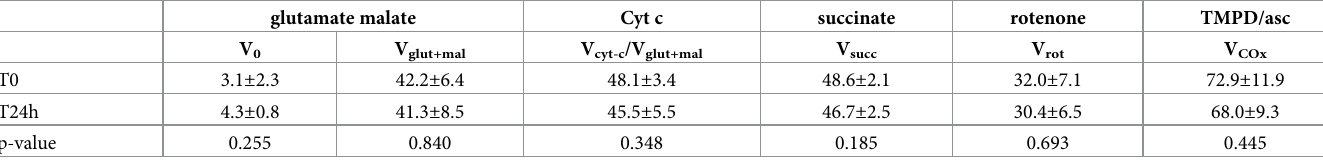
Table 1. Respiration rates of control cardiac human fibers in dependence on the storage